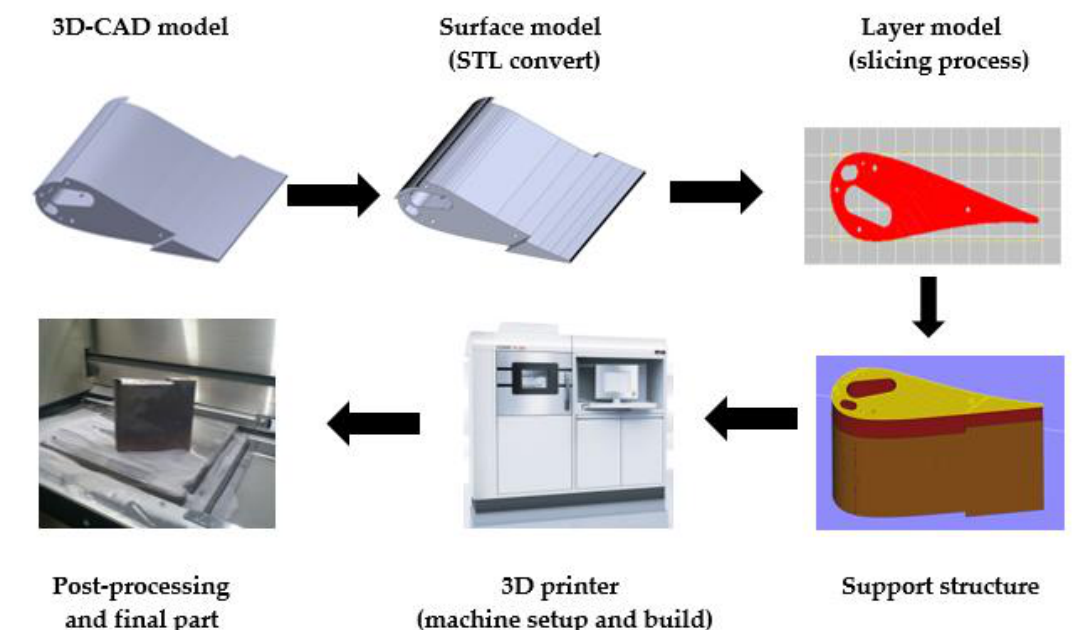
Figure 4. 3D printing process chain for the example of a turbine blade produced by means of DMLS technique with the use of EOS Maraging Steel MS1 in the form of powder; based on references [36,37].